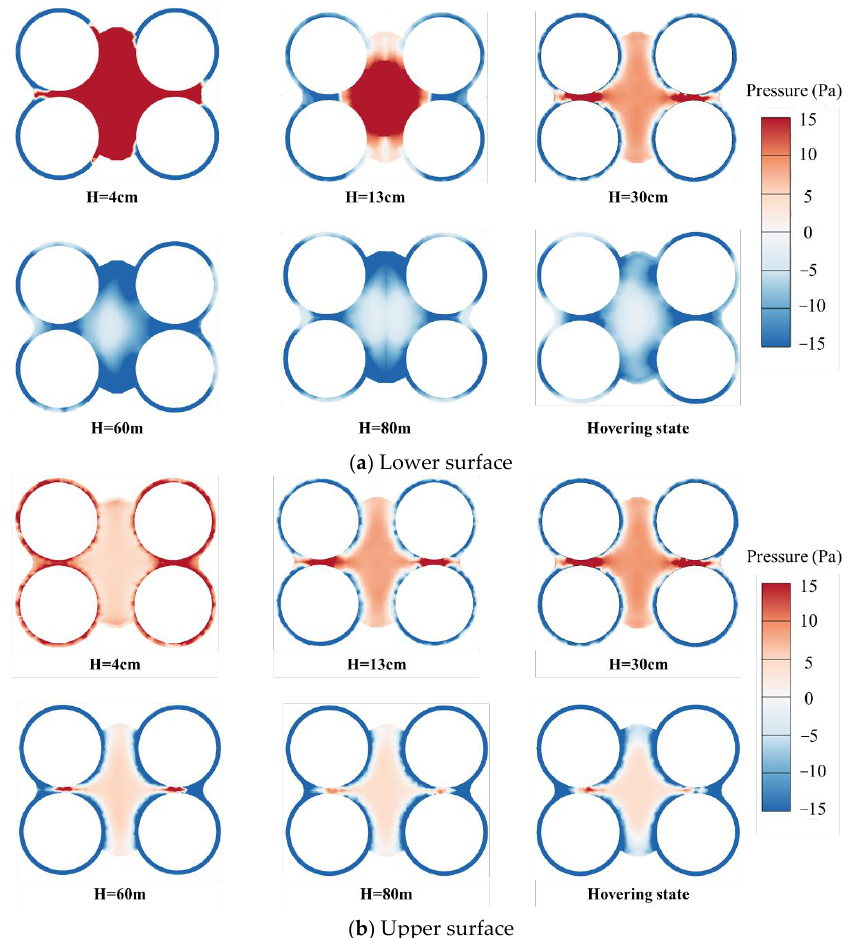
Figure 20. Pressure contours in body interference area.